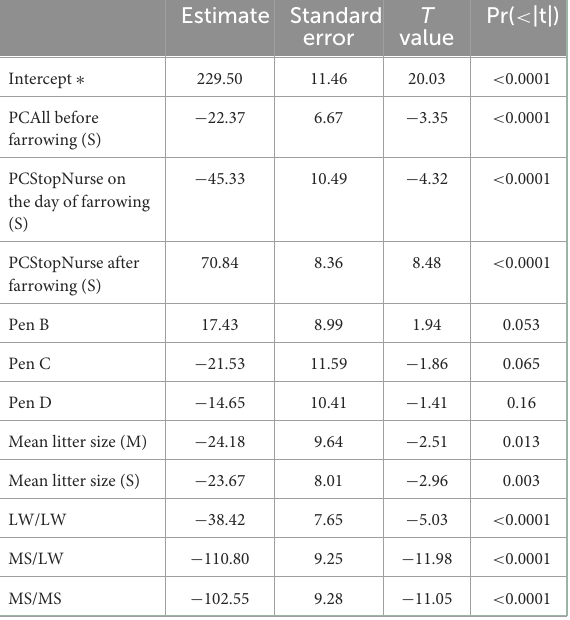
TABLE 3 Estimates of the effects of behavioral traits and other fixed effects on ADG piglet growth (g/d) from D0 to D7. Estimate Standard